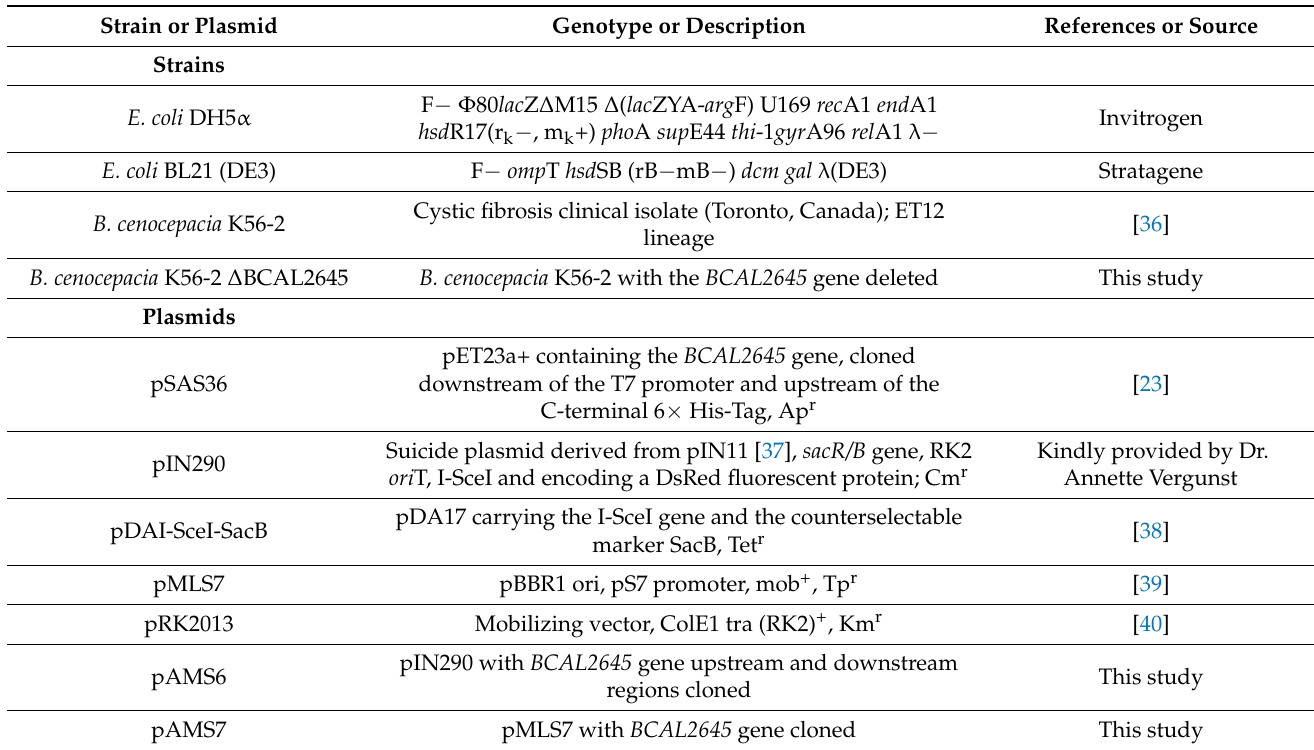
Table 1. Bacterial strains and plasmids used in this